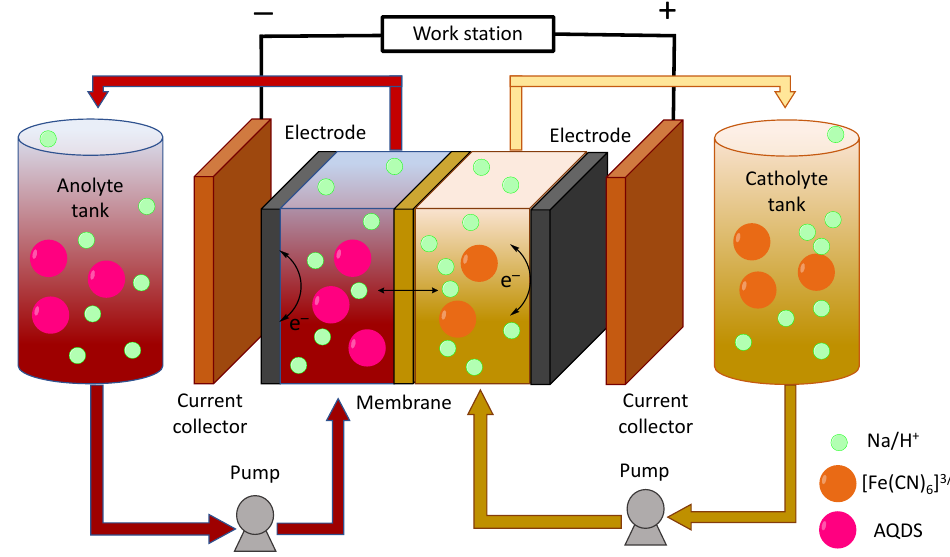
Figure 1. Scheme of an RFB using AQDS and Na 4 [Fe(CN) 6 ] as redox – active materials. During the charging process (see Scheme 1), the one step two-electron reduction of AQDS takes place in the negative electrolyte (anolyte, negolyte). In this process, electrons move from the positive electrode to the negative one by the external circuit and sodium ions migrate through the IEM in the same direction as the electrons to maintain the elec- troneutrality of the system. By contrast, in the positive electrolyte (catholyte, posolyte), a ferrocyanide ion releases one electron to the inert electrode, oxidizing ferricyanide to